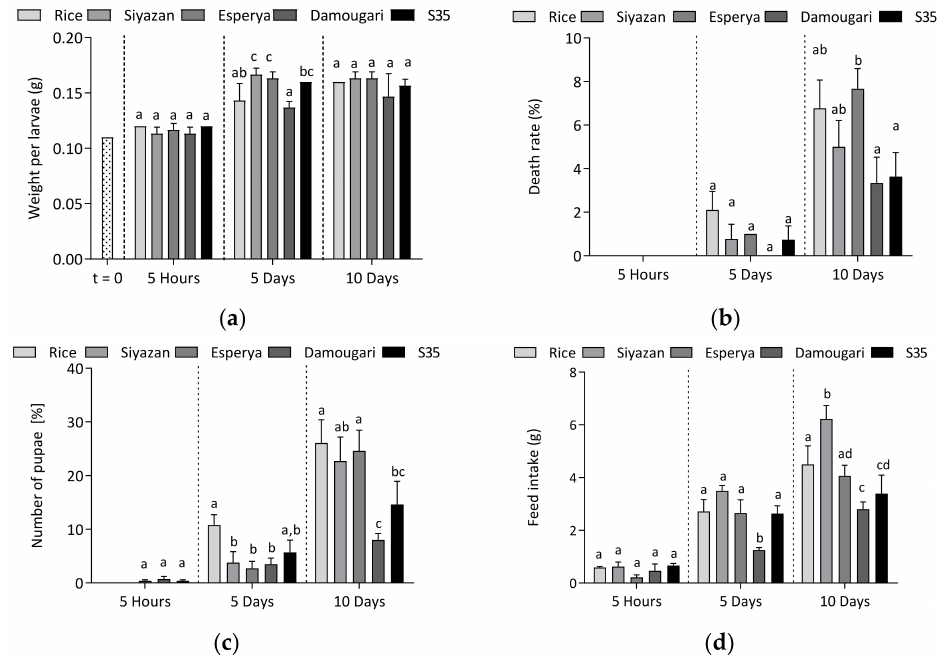
Figure 2. Changes in ( a ) weight of larvae, ( b ) larval death rate, ( c ) number of live pupae and ( d ) feed intake as a function of feeding duration. Different letters indicate statistically significant differences at p = 0.05 (Tukey test). Figure 2b: after 5 days of feeding, the larvae from rice flour tended to show the